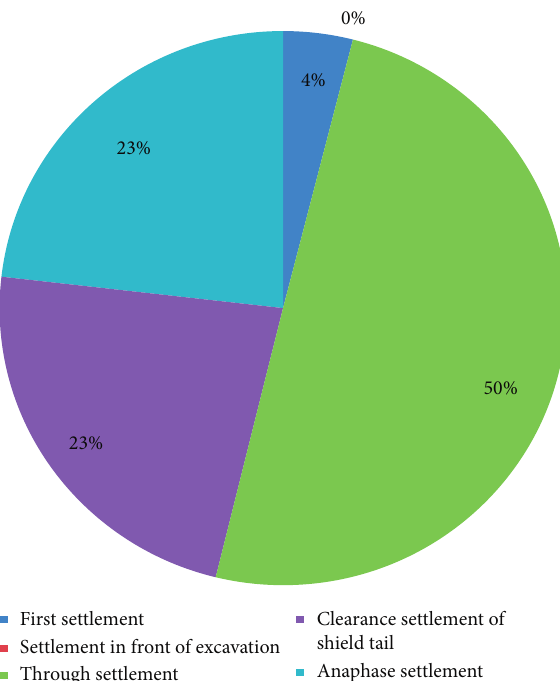
Figure 18: Settlement scale map of cross section 1 (grouting reinforcement).